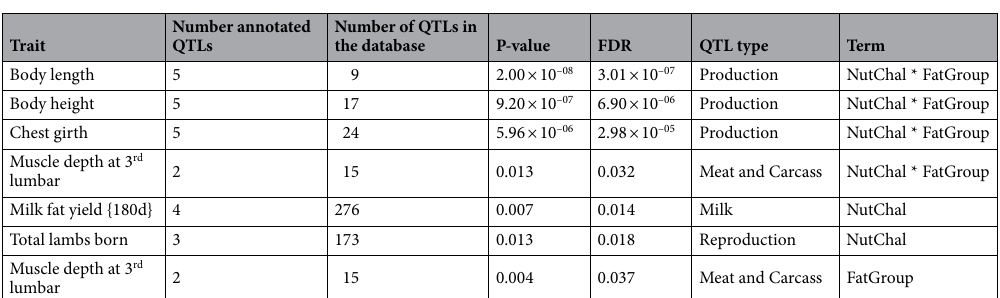
Table 3. Enrichment results for the quantitative trait loci annotated within the genomic coordinates for the differentially methylated regions for all three terms of the multifactorial model (Nutchal * FatGroup, NutChal, and